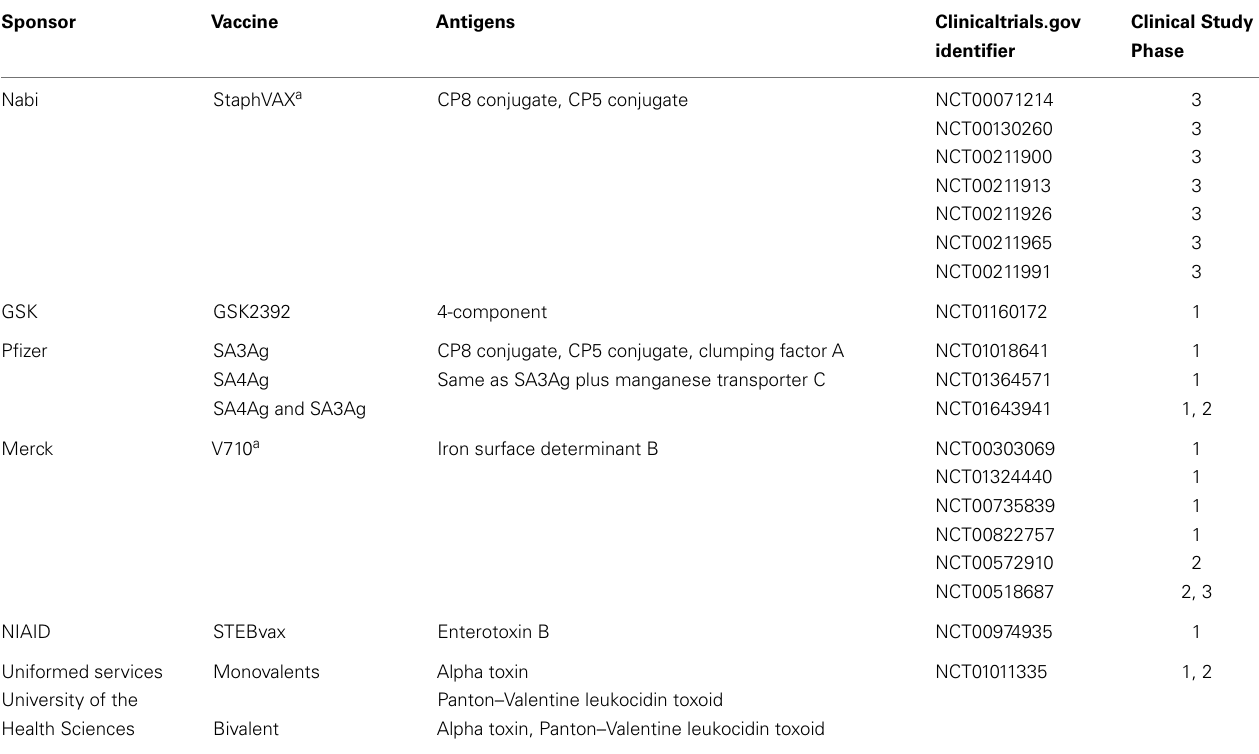
Table 1 |Vaccines containing S. aureus antigens that have been evaluated in human clinical trials as reported on clinicaltrials.gov